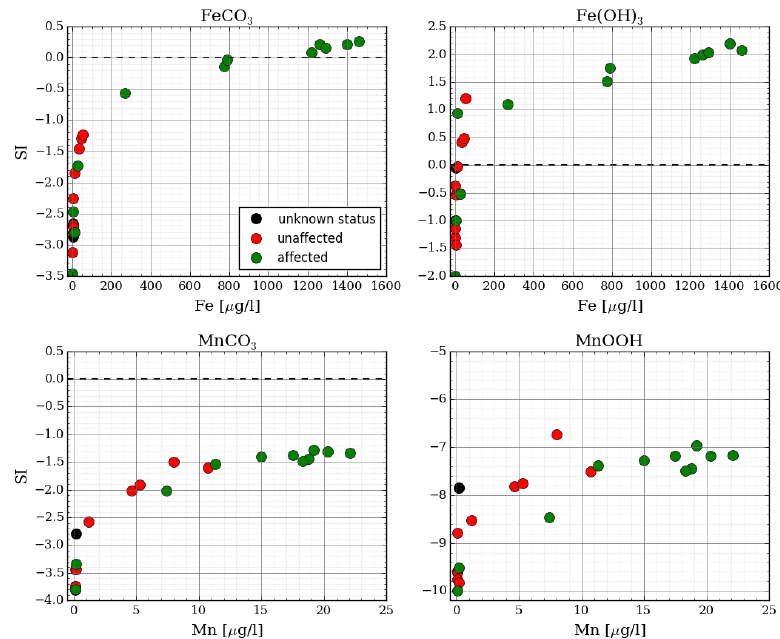
Figure 5. Correlation between Fe(II) and Mn(II) and the saturation of groundwaters in respect to the common aquifer minerals rhodochrosite (MnCO 3 ), siderite (FeCO 3 ) and iron and manganese oxides (Fe(OH) 33 and MnOOH). The dashed line indicates mineral equilibrium (SI = 0) with minerals likely to precipitate at SI > 0 and dissolve at SI < 0. Green symbols relate to clogging-affected bores, red symbols represent unaffected bores, light green symbols represent mildly/moderately affected bores, while black symbols relate to bores where the severity of clogging was unknown. Calculations were performed by PHREEQC using the PHREEQC-2 thermodynamic database.